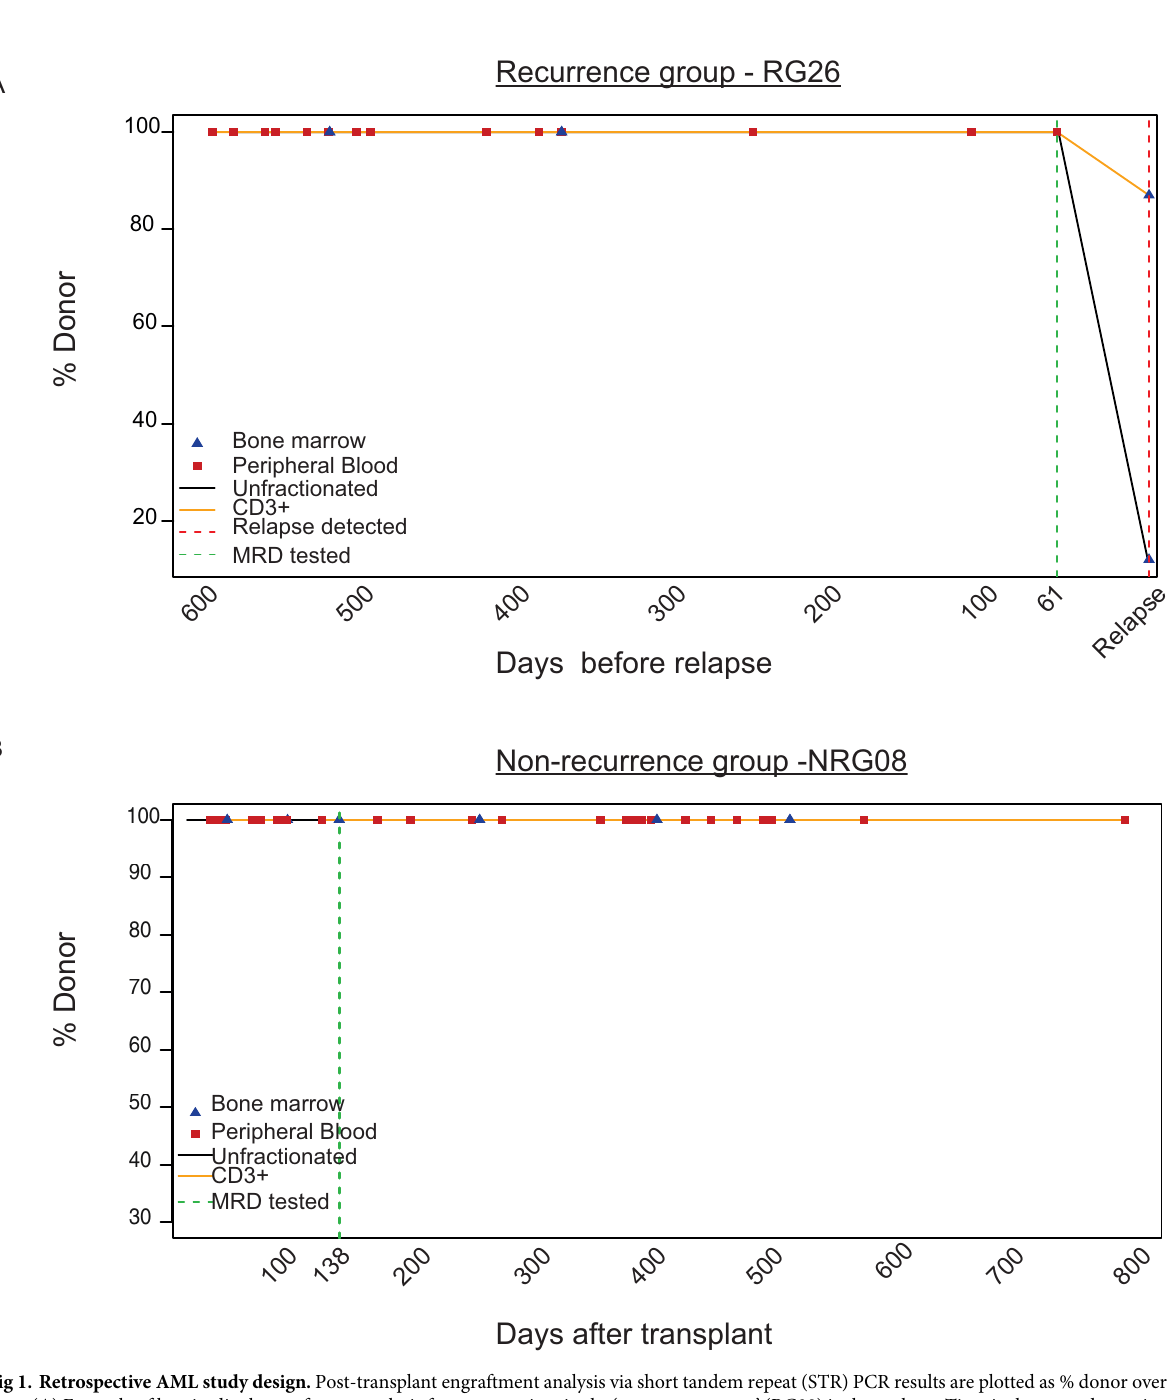
Fig 1. Retrospective AML study design. Post-transplant engraftment analysis via short tandem repeat (STR) PCR results are plotted as % donor over time. (A) Example of longitudinal engraftment analysis from one patient in the ‘recurrence group’ (RG29) is shown here. Time is shown as days prior to relapse. Red dotted line denotes the relapse time point, while the green dotted line indicates a fully-engrafted sample within the 20–100 day pre-relapse range. (B) Example of longitudinal engraftment analysis from one patient in the non-recurrence group (NRG08) is shown here. Time is shown as days post-HCT. The green dotted line shows a fully engrafted time-point that tested for MRD, with > 3 months of prior and > 2 years of subsequent follow-up with full